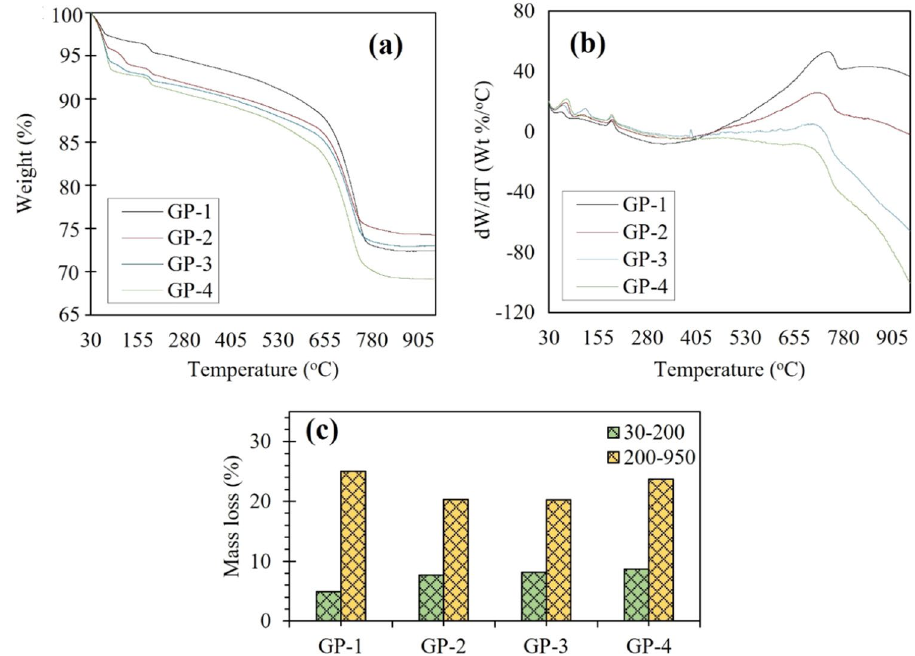
Figure 11. ( a ) TGA and ( b ) DTG curves of the Geopolymer composites in nitrogen atmosphere; ( c ) comparison of mass loss between 30–200 and 200–950 °C.